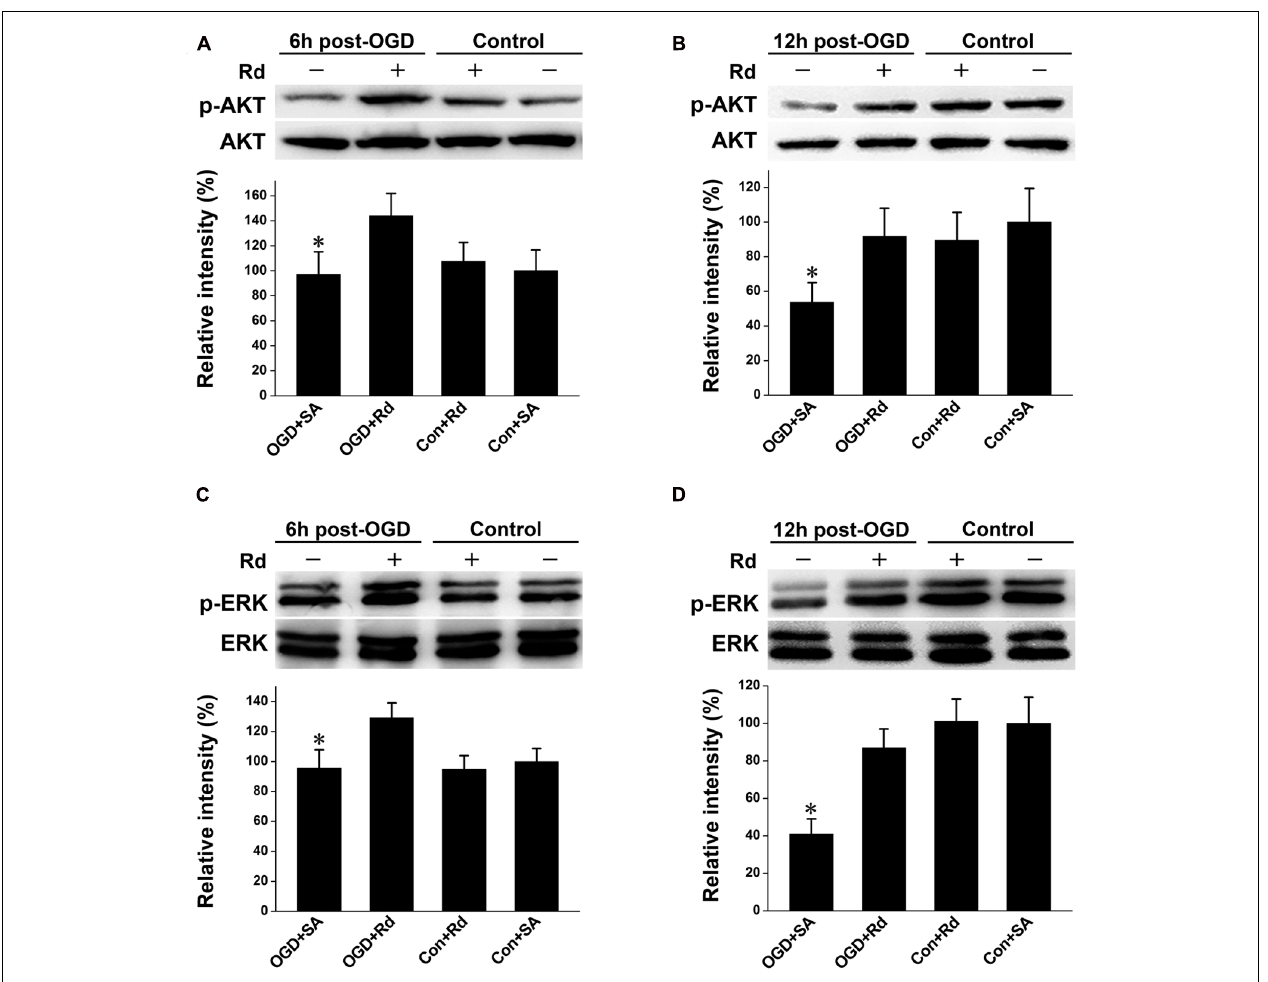
FIGURE 3 | Effect of Rd on phosphorylation of AKT and ERK1/2. Cultured astrocytes were harvested 6 and 12 h after OGD. Western blotting analysis of proteins extracted from astrocytes was performed using antibodies against p -AKT/AKT (A : 6 h and B : 12 h ) or p -ERK1/2